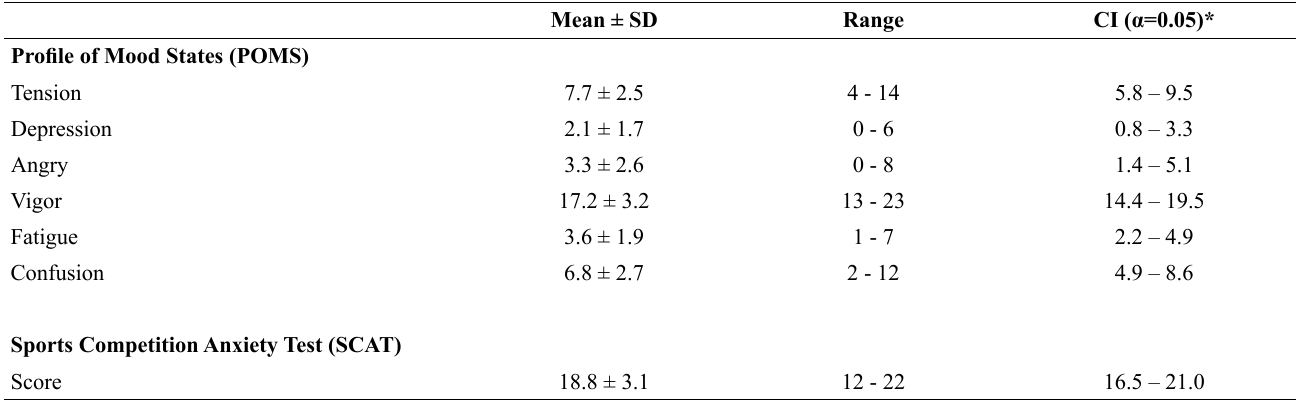
Table 2. Profile of Mood States (POMS) and Sports Competition Anxiety Test (SCAT) results of the slalom kayakers.